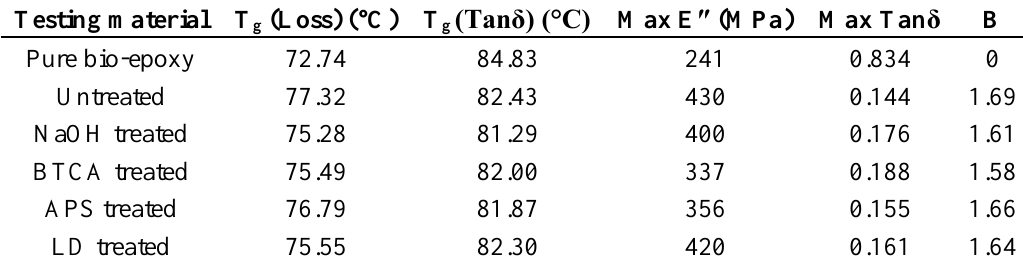
Figure 3. Effect of treatments on loss modulus of resin and FE composites. Table 4. Thermal-mechanical properties of untreated and treated